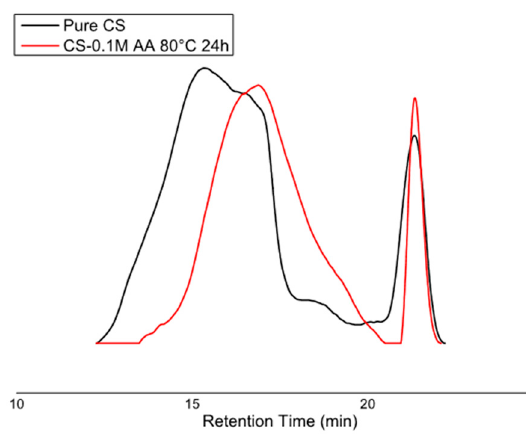
Figure 7. GPC elution profiles of pure chitosan and 2% w/v chitosan in 0.1 M acetic acid solution exposed to 80 °C for 24 h.